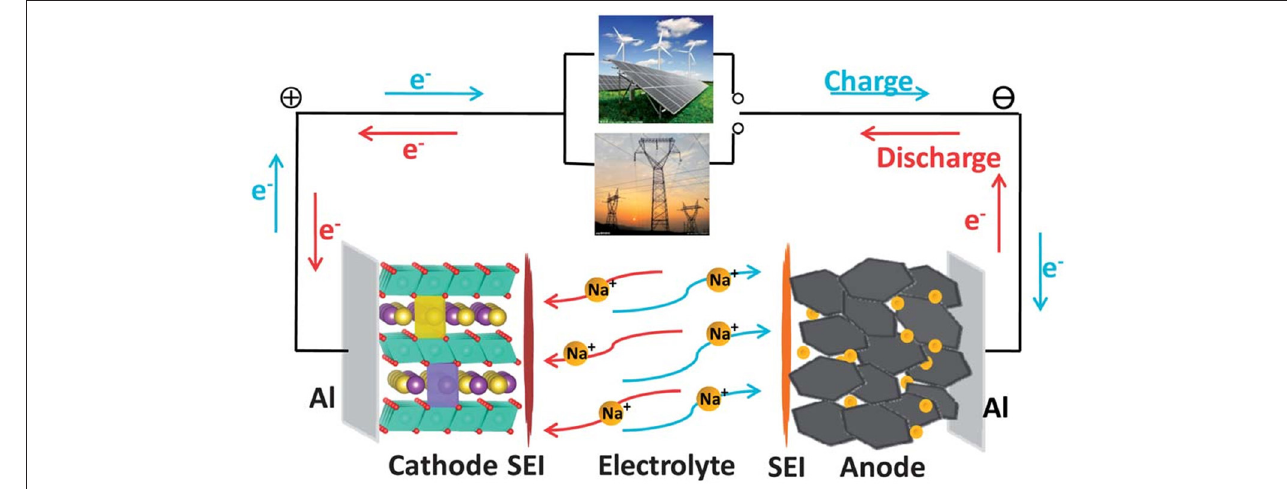
FIGURE 1 | Principe diagram of sodium ion battery